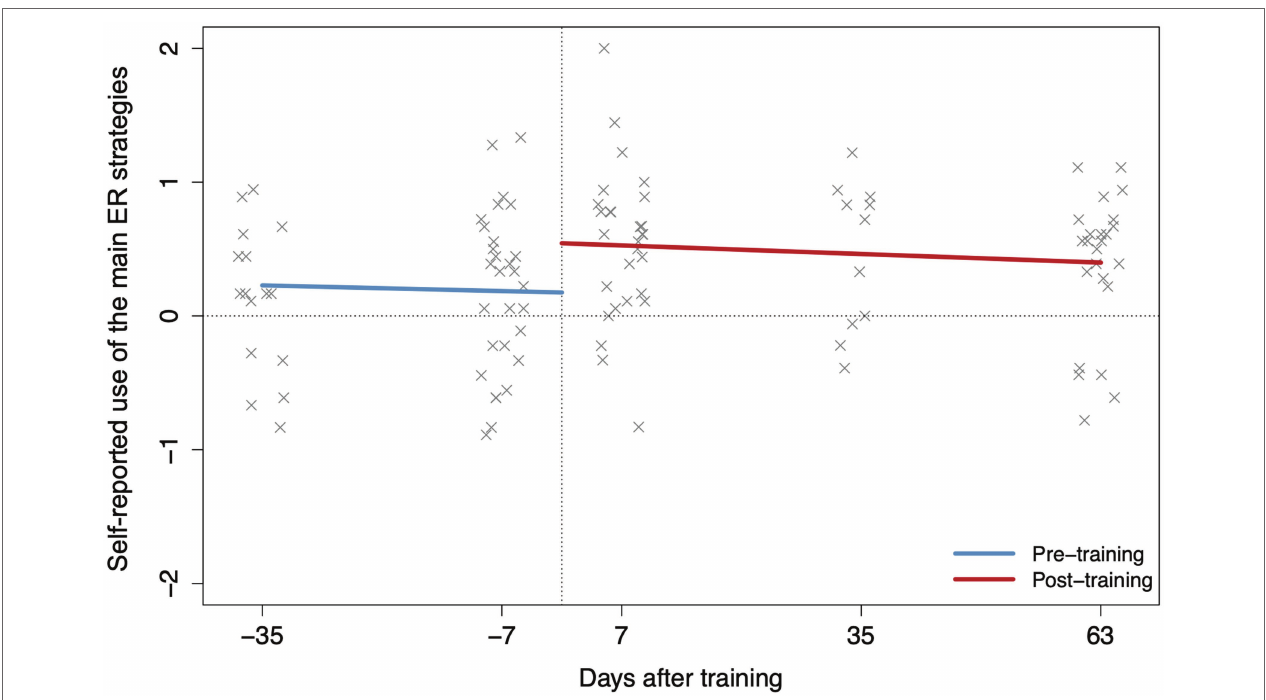
FIGURE 4 | Positive ER training effects over time on use of main ER strategies for all the available time points of the entire sample.